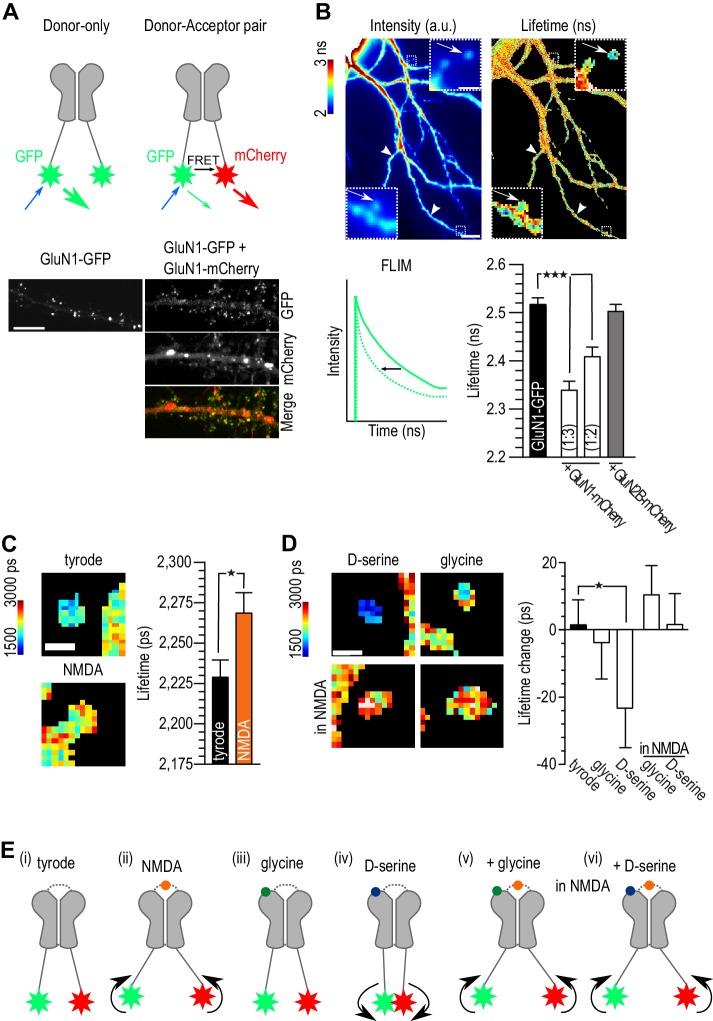
D-serine binding alone differently modulated NMDAR c-terminal conformation.(A) Schematic representation of experimental design (top). Hippocampal neurons 14 div, transfected at 10 div with: GluN1-GFP (donor) or GluN1-GFP plus GluN1-mCherry (acceptor, bottom). Both conditions were co-transfected with GluN2B-Flag. Scale: 10 µm. (B) Example of GluN1-GFP fluorescent (left) and FLIM image (right). NMDAR clusters (spines clusters: arrows; shaft clusters: arrow heads, top) lifetime in nanoseconds (ns) quantification (bottom). Scale: 10 µm, insert 1 µm. Schematic representation of lifetime decay of a donor-only (full line) and of the donor in the presence of the acceptor (dashed line, bottom left). Comparison between GluN1-GFP lifetime alone (donor-only), co-transfected with GluN1-mcherry with a ratio 1:3 or 1:2 (donor-acceptor pair) and co-transfected with GluN2B-mCherry (negative control). GluN1-GFP: n = 70, GluN1-GFP + GluN1-mCherry (1:3): n = 88, GluN1-GFP + GluN1-mCherry (1:2): n = 44, GluN1-GFP + GluN2B-mCherry: n = 60 spines and shaft clusters; p<0.0001, One-way analysis of variance, followed by Dunnett's Multiple Comparison Test, ***p<0.0001 (bottom right). (c) Example of FLIM image of GluN1-GFP/GluN1-mCherry clusters after addition of tyrode (control) or NMDA (left). Quantification of GluN1-GFP lifetime (right). Tyrode: n = 291, NMDA: n = 124; p=0.0165, F = 1.719, Unpaired t test, one-tail. (D) Example of FLIM image of GluN1-GFP/GluN1-mCherry clusters after addition of D-serine or glycine (top) in tyrode only or in the presence of NMDA (bottom). Quantification of GluN1-GFP lifetime change (lifetime after minus the lifetime before co-agonist addition, right). Tyrode: n = 291, glycine: n = 110, D-serine: n = 103, glycine in NMDA: n = 268, D-serine in NMDA: n = 233 spine and shaft clusters; tyrode p=0.4234, r2 = 0.0001, glycine p=0.3650, r2 = 0.0011, D-serine p=0.0255, r2 = 0.0368, glycine in NMDA p=0.0949, r2 = 0.0065, D-serine in NMDA p=0.4348, r2 = 0.0001, Paired t-test, one-tail, before and after, *p<0.05. Data are represented as mean ± s.e.m. (E) Schematic representation of the c-terminus tails of the NMDAR in basal conditions (tyrode, (i) or in the presence of NMDA (ii), the co-agonists alone (iii, iv) or in activating conditions (co-agonists together with NMDAR, (v, vi).